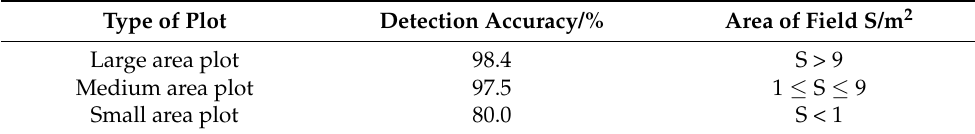
Table 7. The detection accuracy and area of Papaver somniferum cultivation